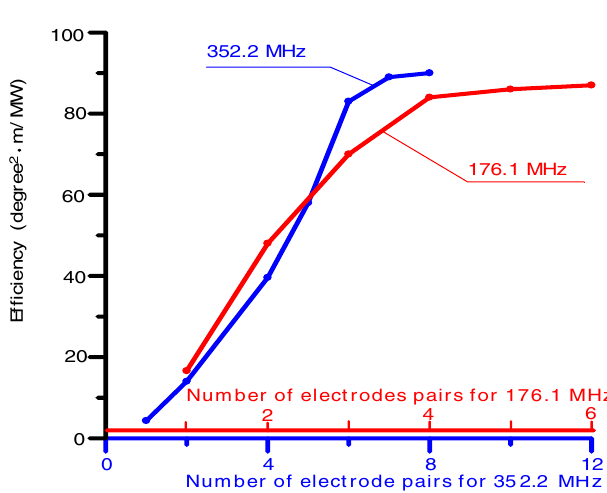
FIG. 8. (Color) Transverse shunt impedance for different structures.